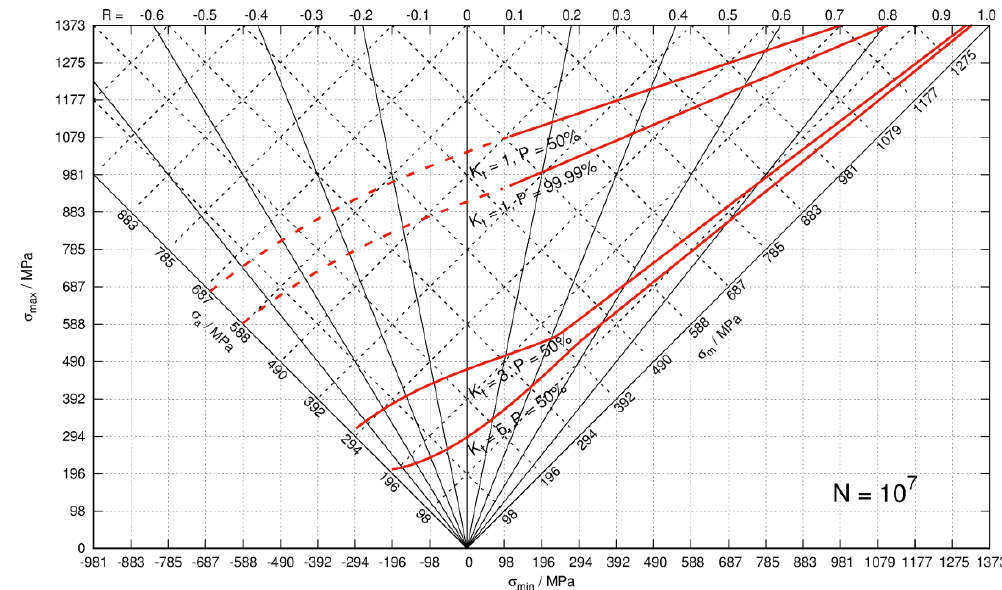
Figure 12. Constant life curve of N = 10 7 with different survival rate.